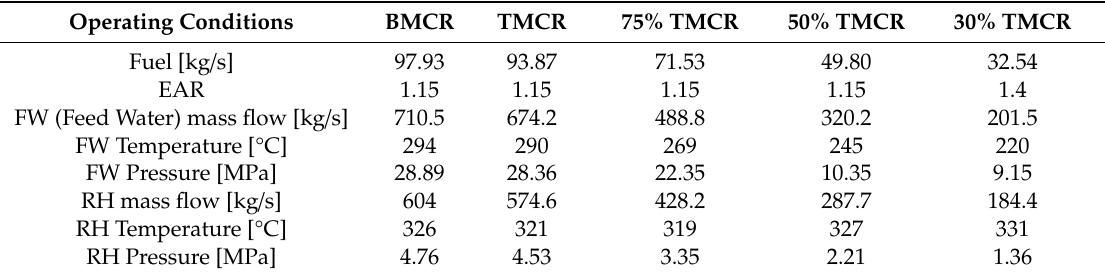
Table A1. Input conditions for the boiler system based on the five load conditions.